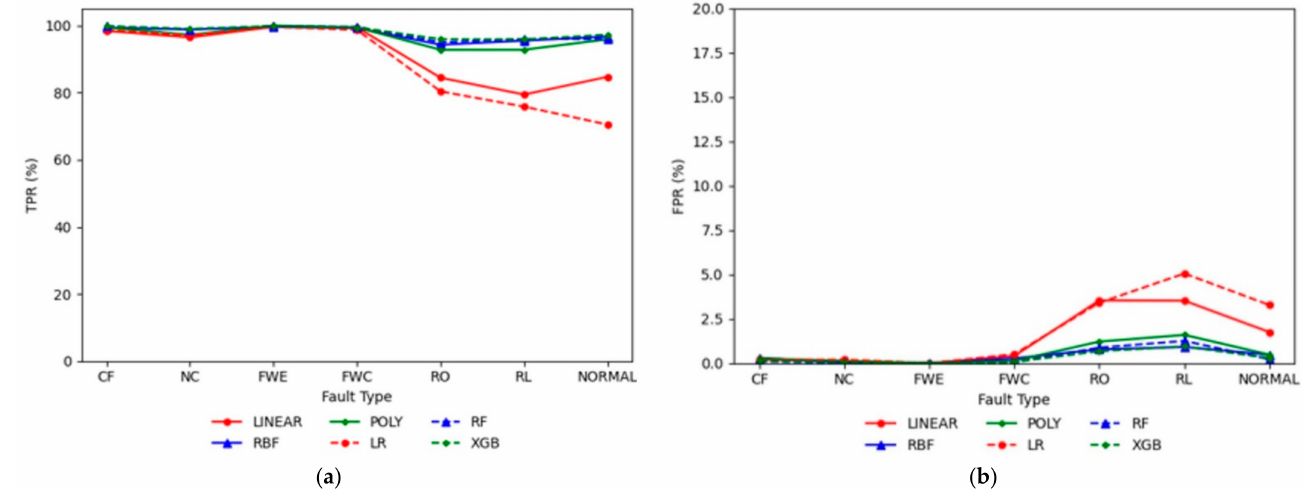
Figure 19. TPR and FPR values for each classification method (Case 1): ( a ) TPR; ( b )